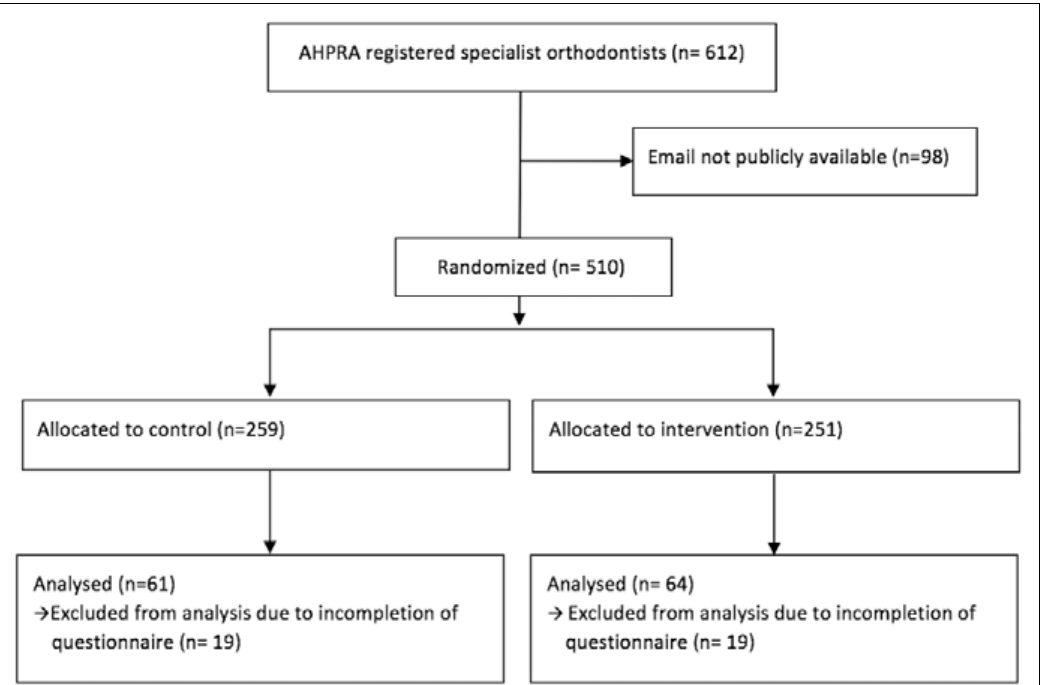
Figure 2. CONSORT flow diagram showing the study design.